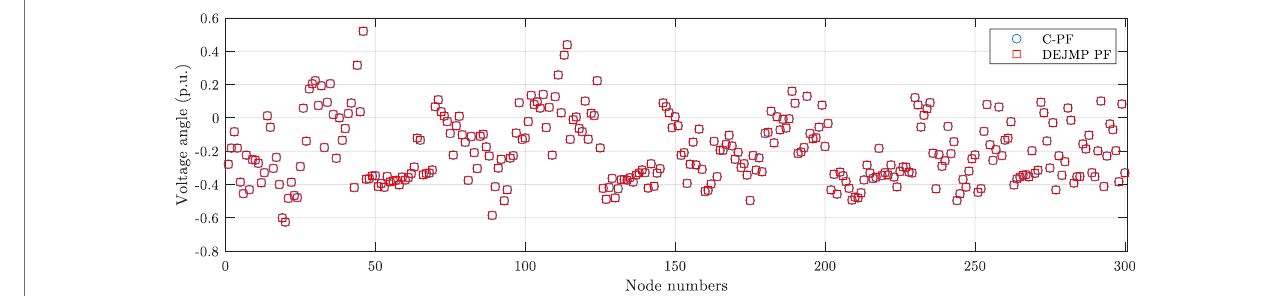
FIGURE 3 | the voltage angle obtained by DEJMP-based PF and C-PF on IEEE-300 bus systems.